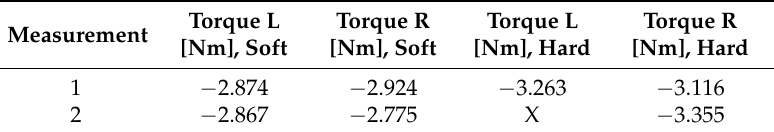
Figure 7. Course of spindle torque during finish operation on hard and soft machining with standard inserts of type 1030. Table 11. Maximum torque on machine spindle during milling process in soft and hard state with standard inserts of type 1030.